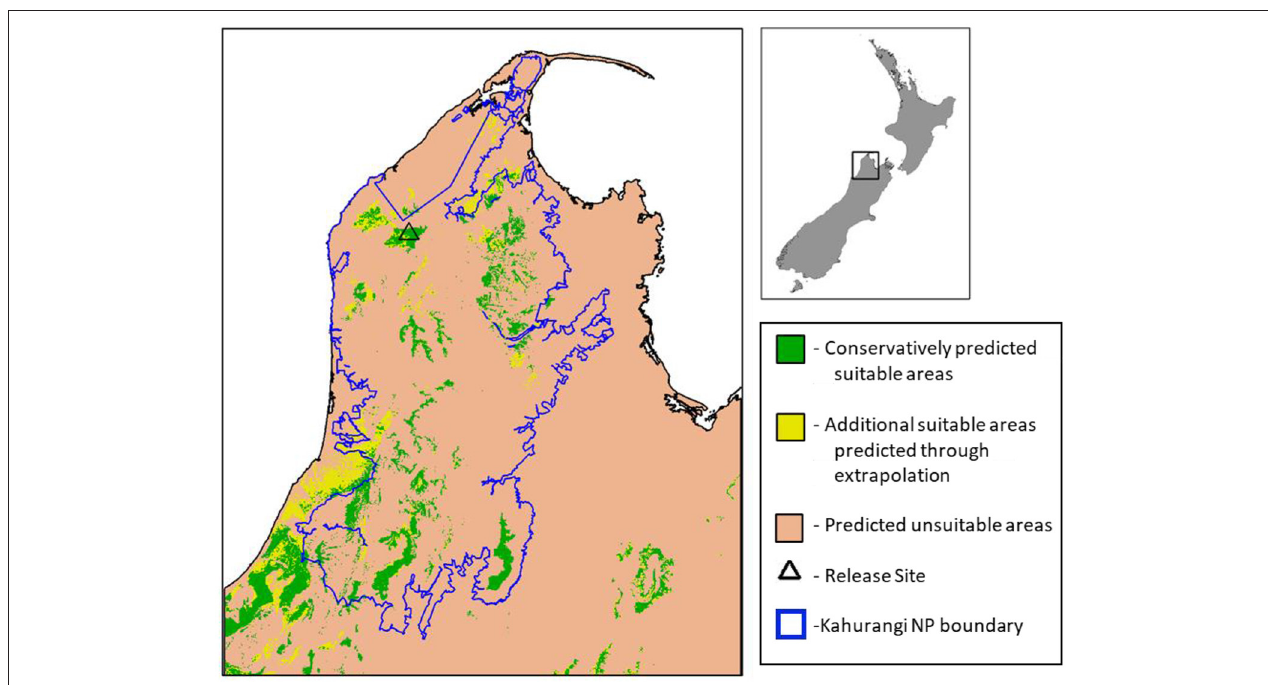
FIGURE 4 | Map of current environmental suitability from a maximum entropy model (Phillips et al., 2006) trained with records from South Island takah ¯ e ( Porphyrio hochstetteri) relict population (Figure 3) . Green areas were identified as suitable by a conservatively fitted model, whereas the yellow areas show the additional space predicted to be suitable when the model fitting was relaxed to allow a greater degree of extrapolation. The conservative model only identifies habitat in environments analogous to those occupied in the models’ input data, whereas the extrapolative model focuses on excluding areas only because they are analogous to unused areas in the species training data. For full details of the methods used to generate these predictions see Supplementary Data Sheet 1